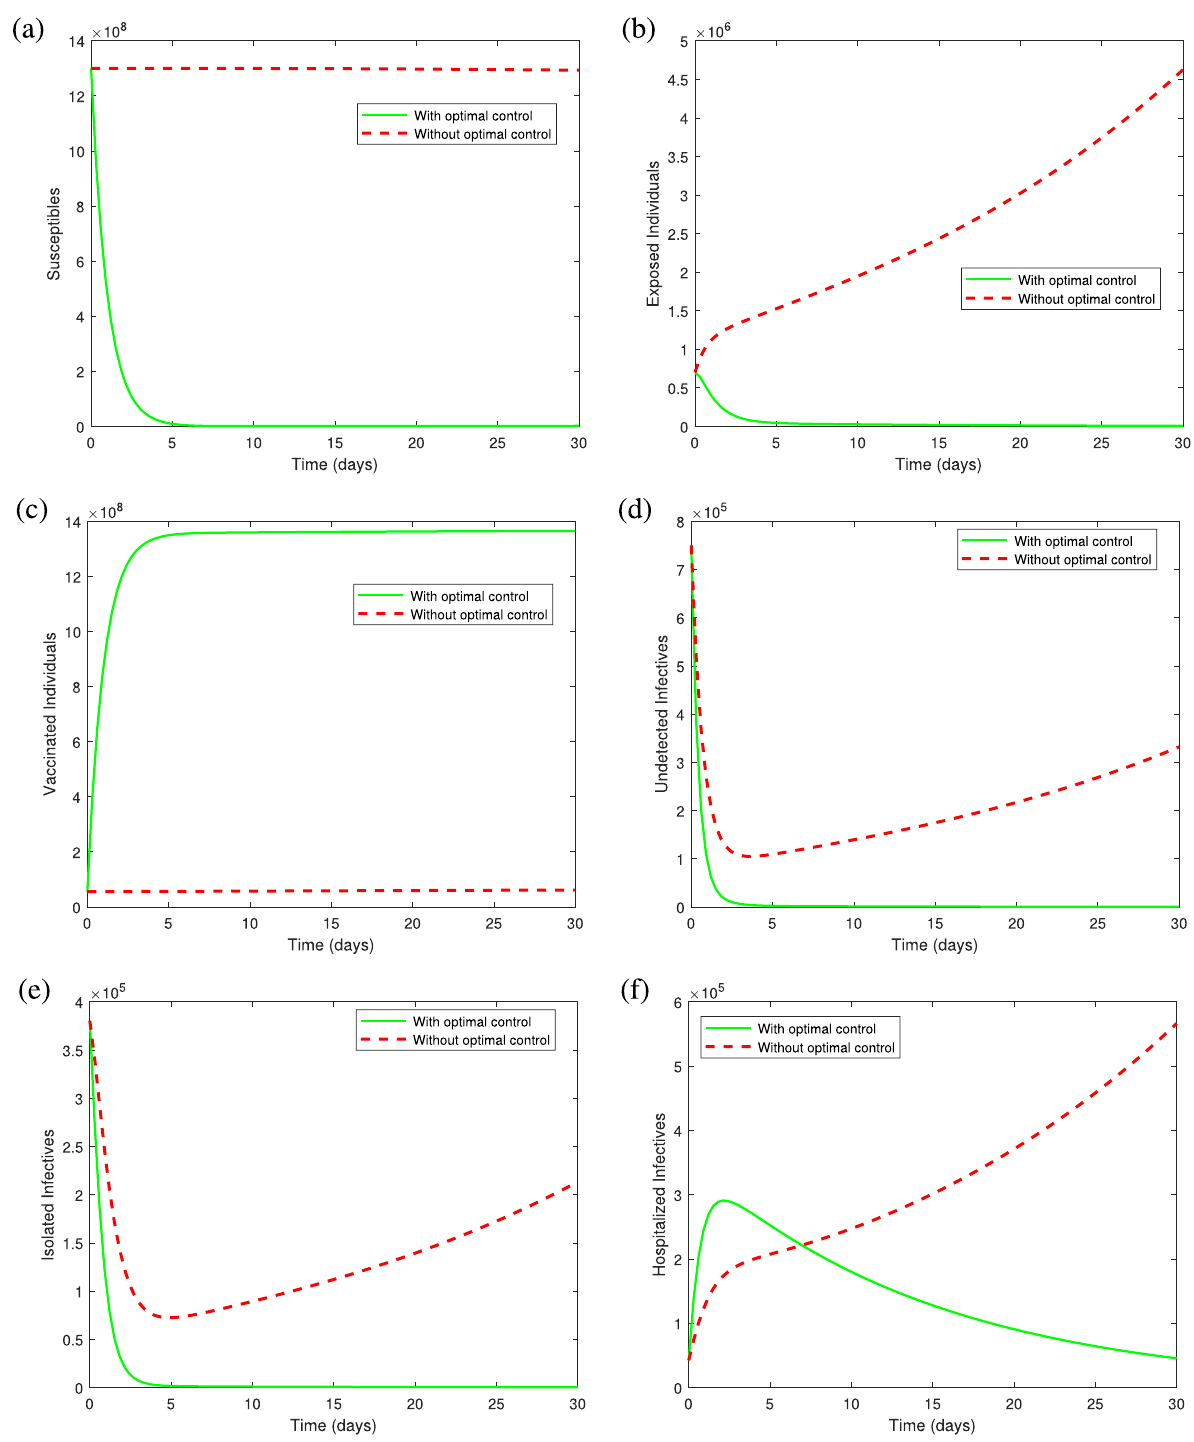
Figure 9. Graphs illustrating the solution trajectories against time (days) from March/25/2021 to April/25/2021 with and without optimal controls u ∗ 1 ( t ) , u ∗ 2 ( t ) , u ∗ 3 ( t ) and u ∗ 4 ( t ) : ( a ) Susceptibles ( b ) Exposed individuals ( c ) Vaccinated individuals ( d ) Undetected infectives ( e ) Isolated infectives ( f ) Hospitalized